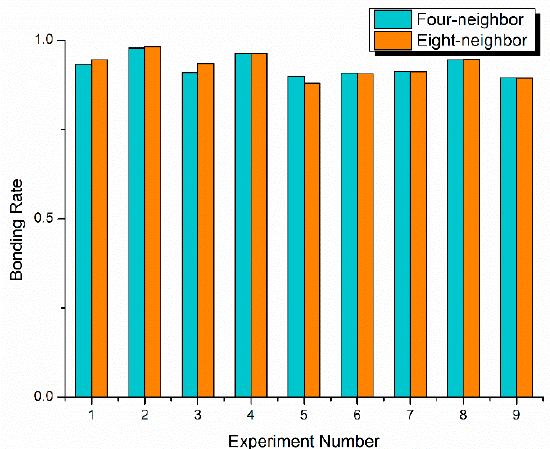
Figure 6. Bonding rate of nine different images using four-neighbor and eight-neighbor sharpening operator patterns.